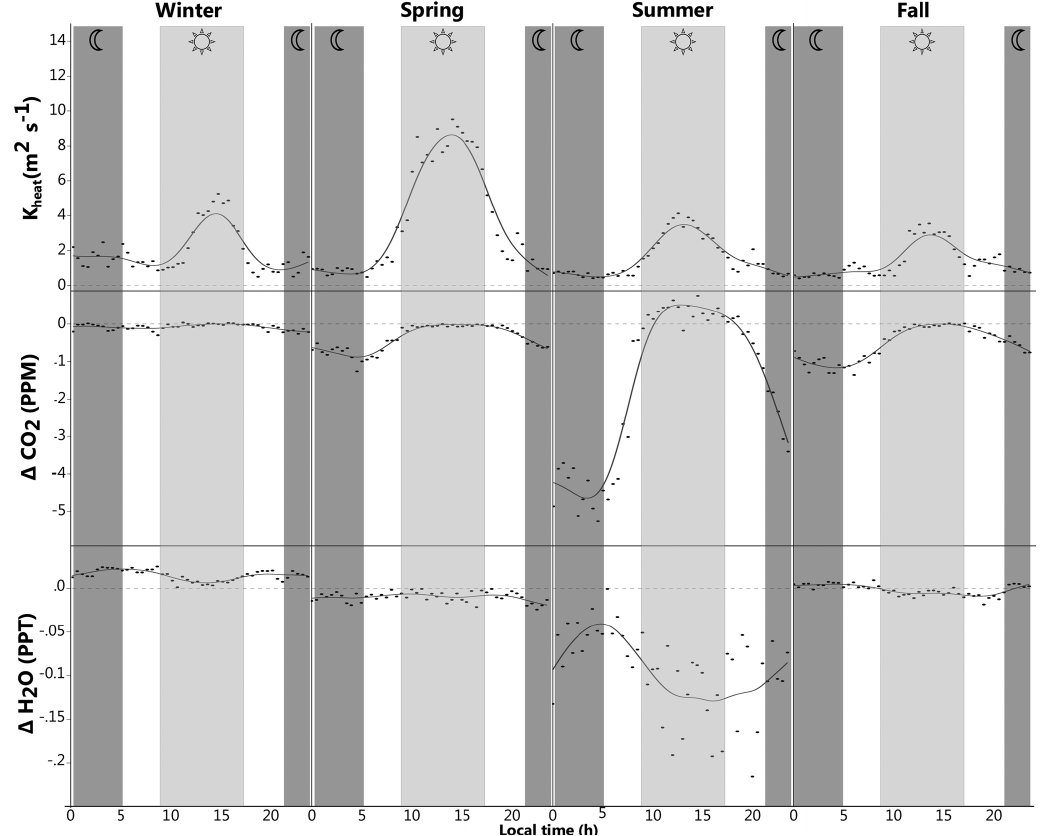
Figure 1. Half-hourly averages of K heat and the concentration gradients of CO 2 and H 2 O across the different seasons (concentration at 40.7m – concentration at 33.3m). The dotted line indicates 0 in all plots; the grey areas indicate the 8h periods representing day and night.